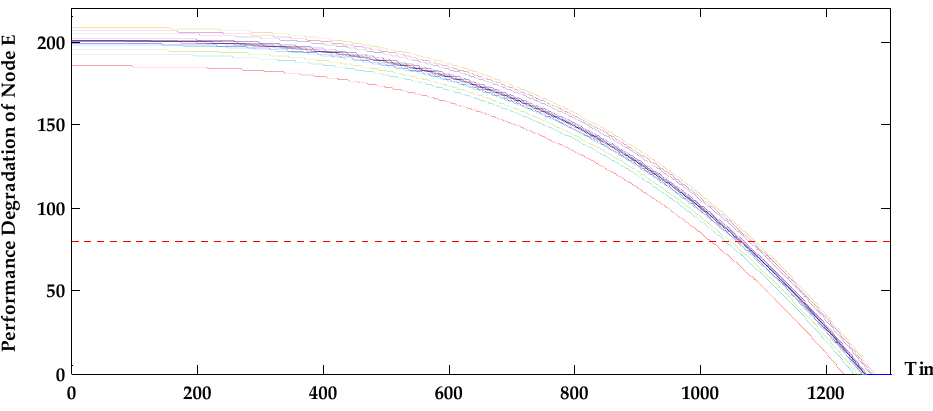
Figure 8. Simulation curve of performance degradation of device E .